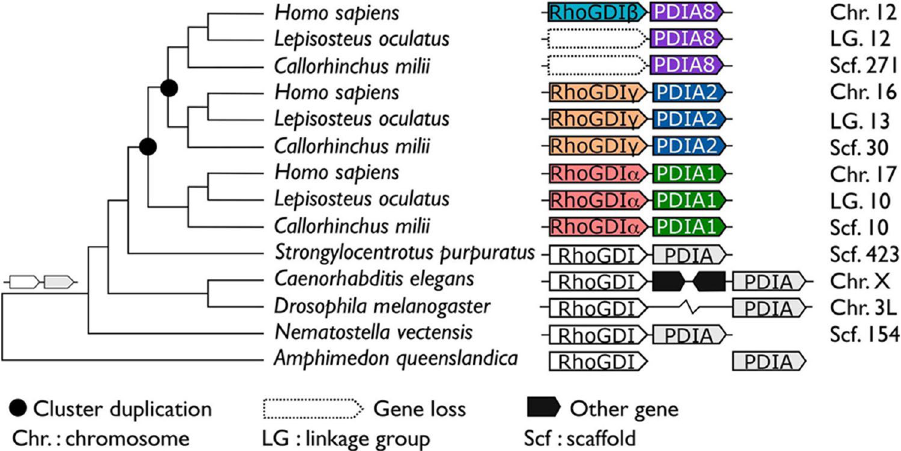
Figure 1. Evolutionary trajectory of the PDI/RhoGDI gene cluster across the animal phylogeny. The emergence of the gene cluster dates back to the last common ancestor shared between bilateria and the cnidarians ( N . vectensis ). In earlier branching animal, e.g. sponges ( A . queenslandica ) or ctenophores (not shown), orthologs to the participating genes are unlinked. In the arthropods, represented by D . melanogaster , the cluster has been disrupted. Two subsequent rounds of cluster duplications in the last common ancestor of the vertebrates gave rise to the three contemporary paralogous gene clusters. The tree topology follows the accepted animal phylogeny, the vertebrate subtrees are arranged according to Supplementary Figure 1 (maximum likelihood PDI family tree). H . sapiens – Sarcopterygii; L . oculatus – Actinopterygii; C . milii – Chondrichthyes; S . purpuratus – Echinodermata; C . elegans – Nematoda; D . melanogaster – Arthropoda; N . vectensis – Cnidaria; A . queenslandica – Porifera. The genomic localizations in the individual species are given next to the cluster representation. In D . melanogaster , the two genes reside on the same chromosome, yet at a distance of > 1